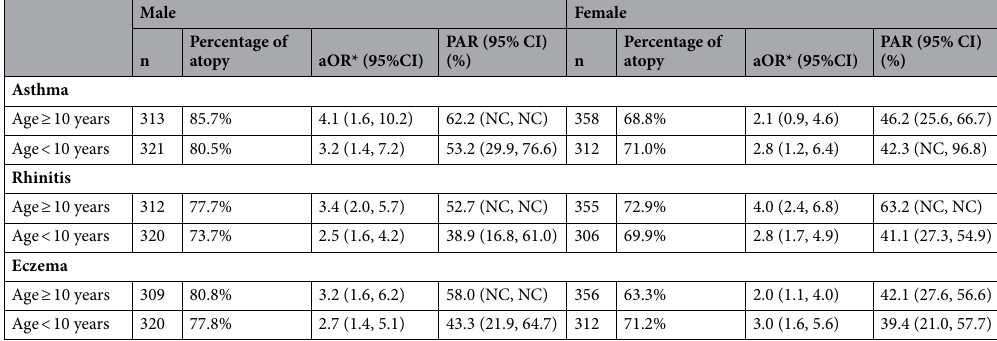
Table 3. Percentage of allergic diseases attributable to atopy, stratified by gender and age. aOR adjusted odds ratio, CI confidence interval, PAR population attributable risk, NC not computed. *Adjusted for age, gender, body mass index, household passive smoking, and season of birth.